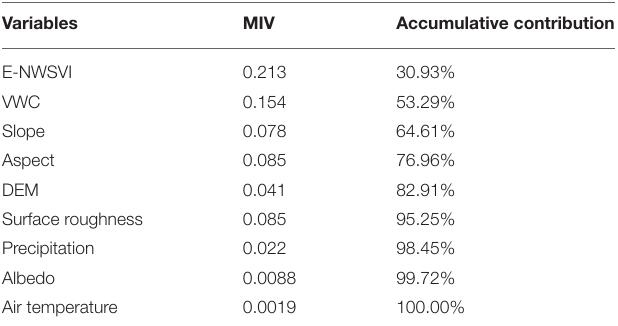
TABLE 3 | Indicator screening for BP-ANN SM model.